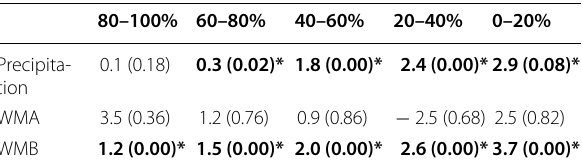
Fig. 6 Variation of precipitation intensities across different quantiles. The colored bars represent the intensity of simulated precipitation (mm for each quantile; red and blue lines indicate the results of WMA (m 2 LOW04